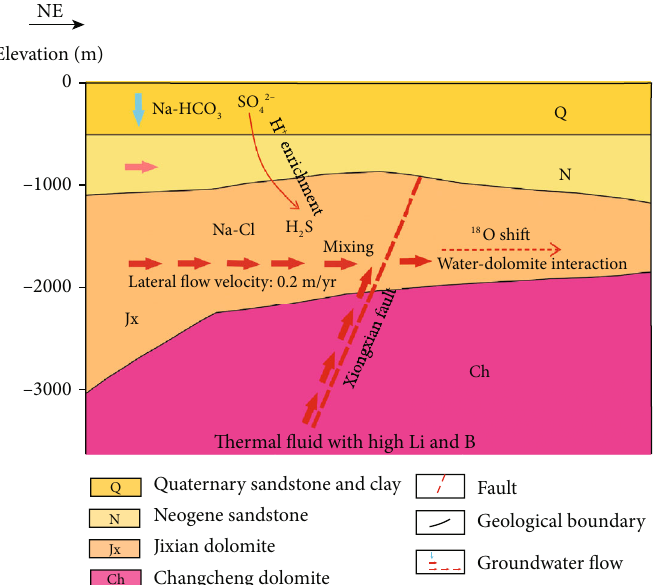
Figure 9: Conceptual model of hydrothermal genesis of Xiongxian karst geothermal